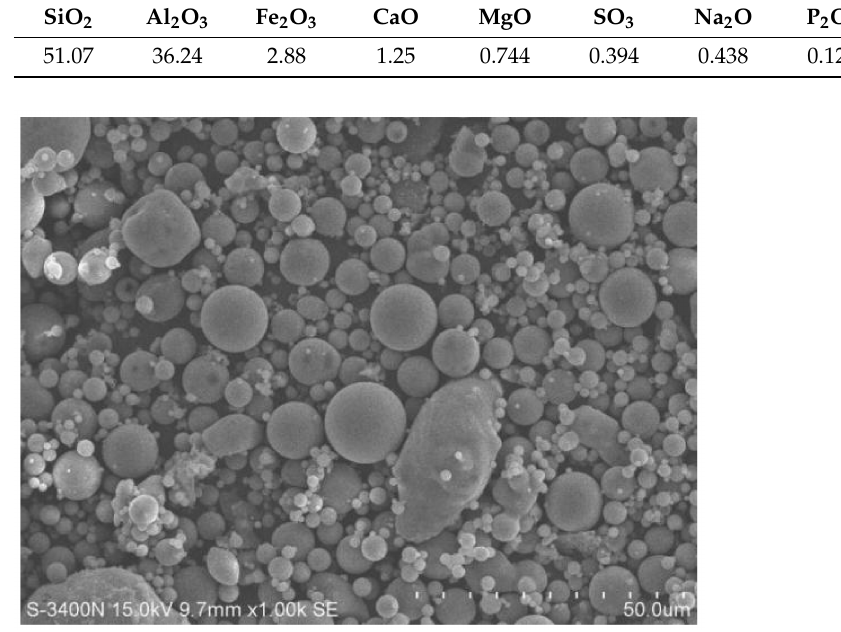
Figure 1. SEM image of fly